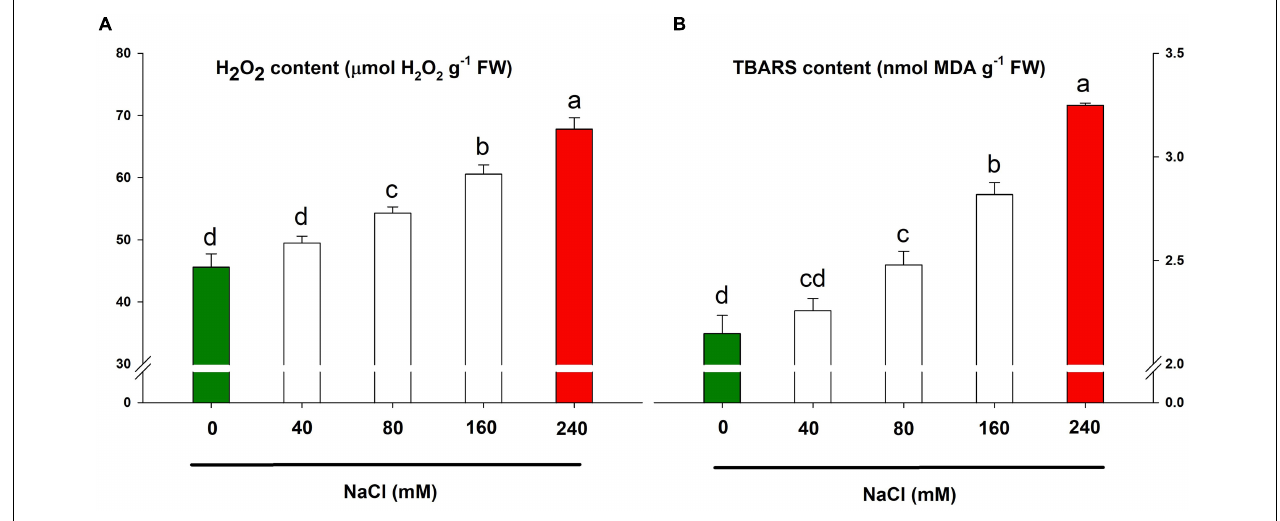
FIGURE 6 | Oxidative stress markers for assessing the salt-sensitivity in lemongrass plants. H 2 O 2 content (A) and TBARS content (B) are depicted here. Each bar represents mean ± SE ( n = 3). Means followed by the same letter(s) do not differ by LSD test at 5% probability level ( α = 0.05). The colors are just visual ques for readers to quickly distinguish between control and most stressed